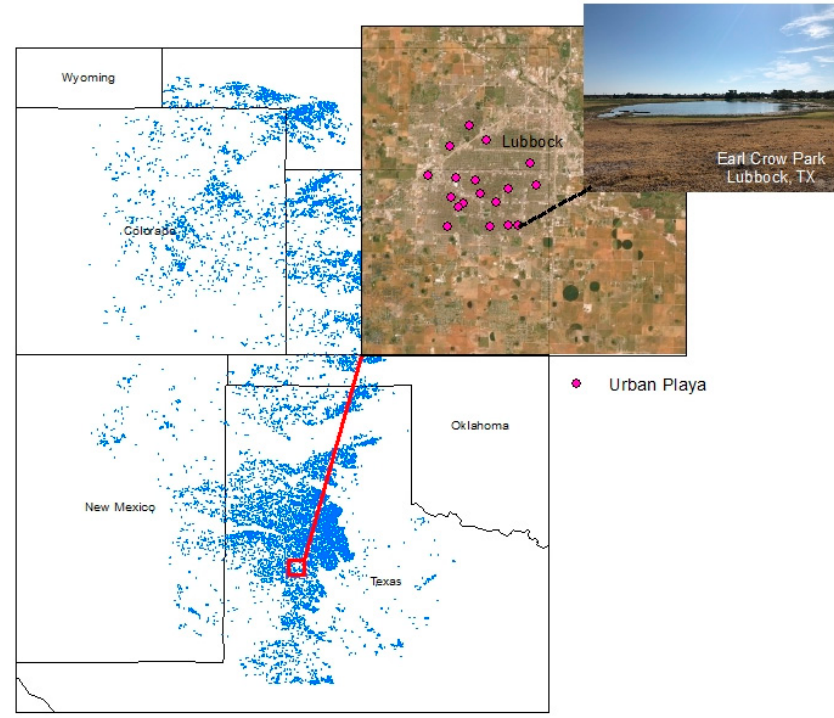
Figure 1. Map of playas of the southern Great Plains, with insets of urban playas sampled in the city of Lubbock, Texas (pink dots), and a photograph of one such example (Earl Crow Park). Basemap from Esri, playa data from Playa Lakes Joint Venture: https://pljv.org/for-habitat-partners/maps-and-data/data-downloads/ (accessed on 17 February 2021); inset map from Esri, photograph by D.M. Husband.